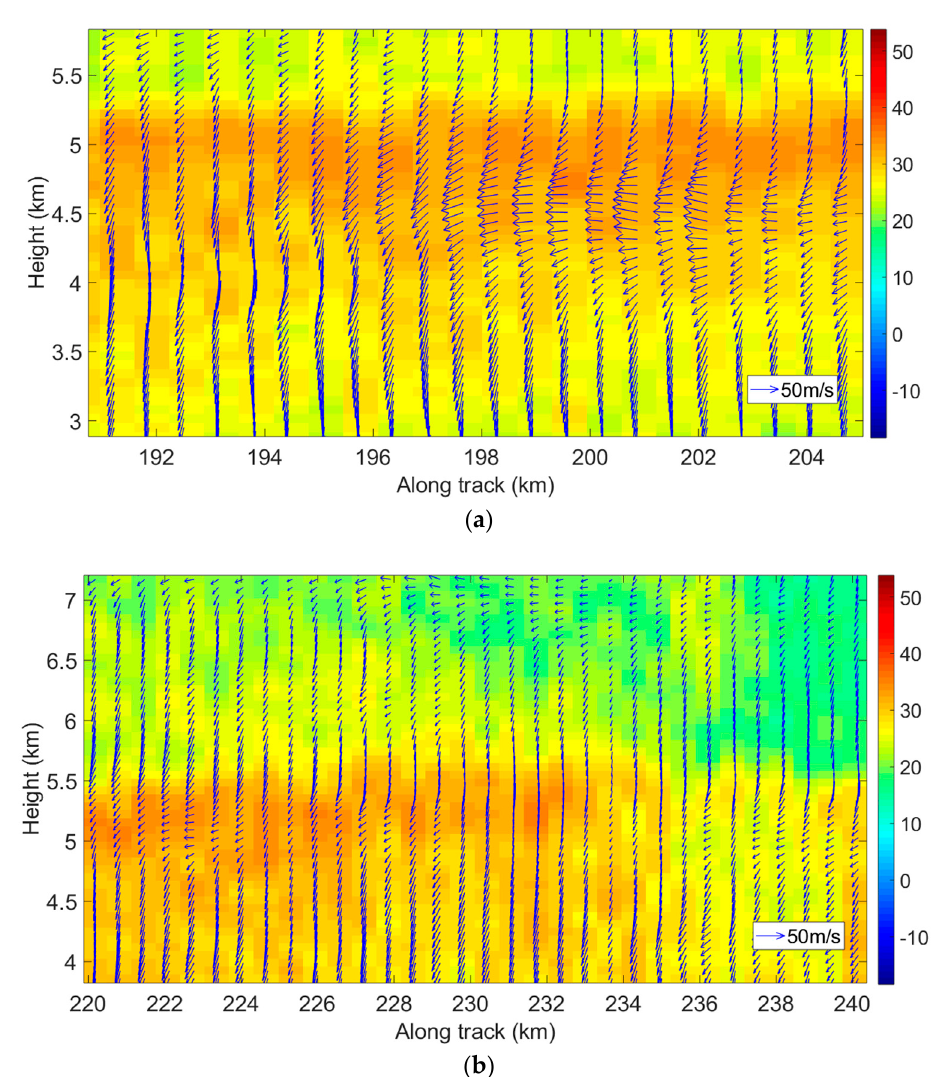
Figure 11. Retrieved horizontal wind vector overlaid on HIWRAP reflectivity. ( a ) Vertical profile of the horizontal winds from 192 km to 204 km along the track; ( b ) Vertical profile of the horizontal winds from 220 km to 240 km along the track.